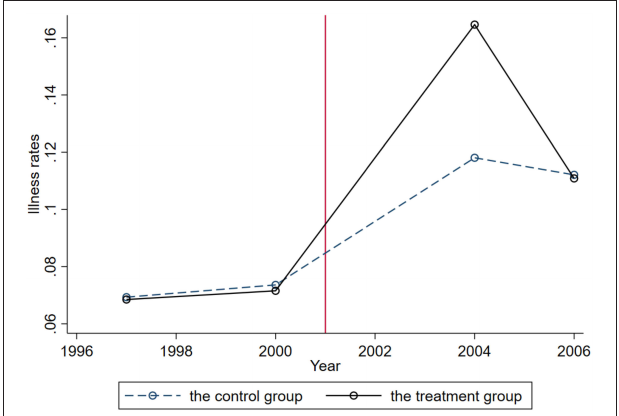
FIGURE 2 | Illness rates in treatment and control groups by years,